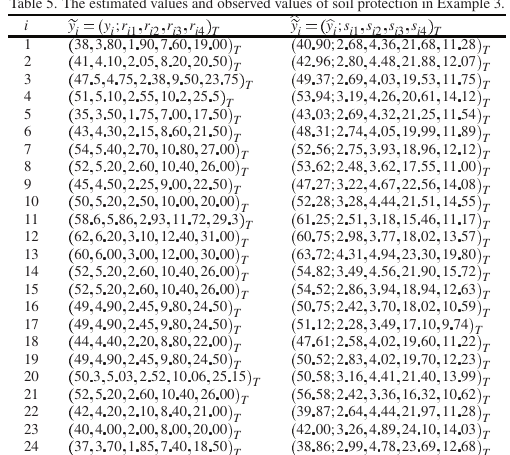
Table 5. The estimatedvaluesand observedvalues ofsoilprotectioninExample3.